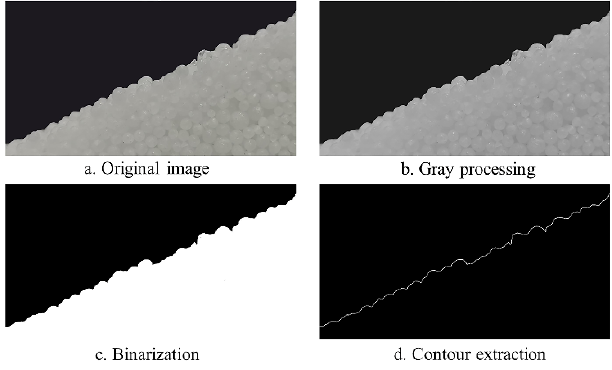
Figure 8. Measurement of the repose angle of urea particles.